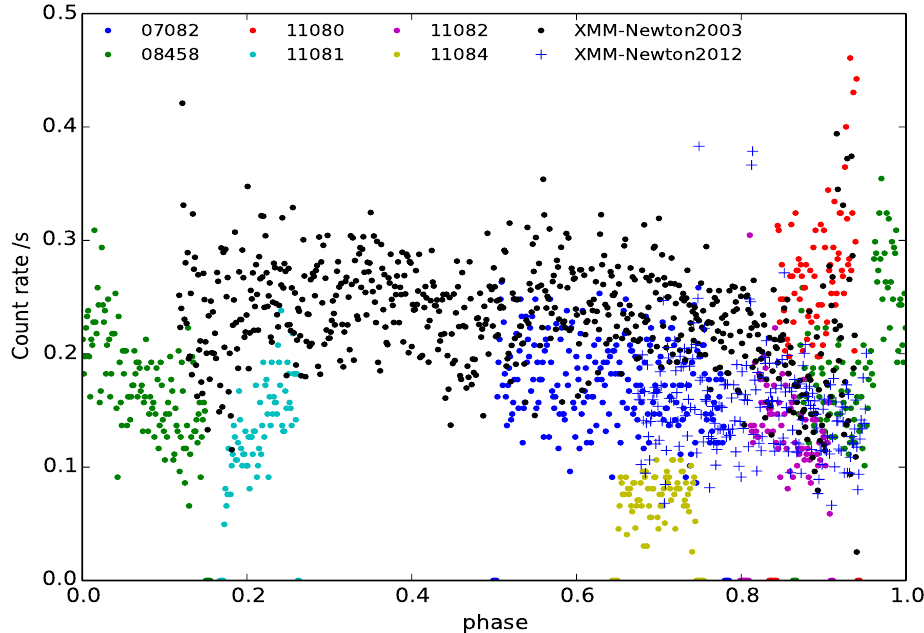
Figure 3. Folded light curve of TV Cassiopeia from six Chandra and two XMM–Newton observations. The orbital period is 1.81260009 days and initial time (phase 0) is 32827.76 in Modified Julian Date. The average size of the error bars is 0.02 s − 1 .